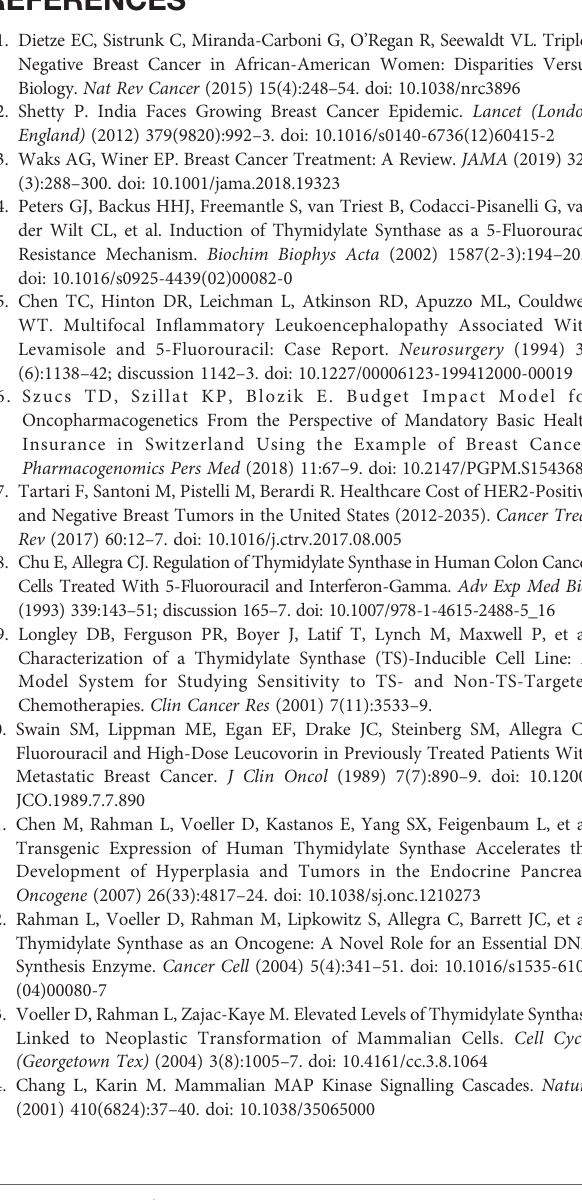
Supplementary Table 1 | The intensity of protein bands of respective proteins in corresponding immunoblot fi gures analysed by ImageJ software. C1, C2, C3- Control samples 1, 2, 3;Cu1, Cu2, Cu3- Curcumin treated samples1, 2, 3;F1, F2, F3-5-FUtreatedsamples1,2,3;F+C1,F+C2,F+C3-Combinationtreatedsamples 1, 2,